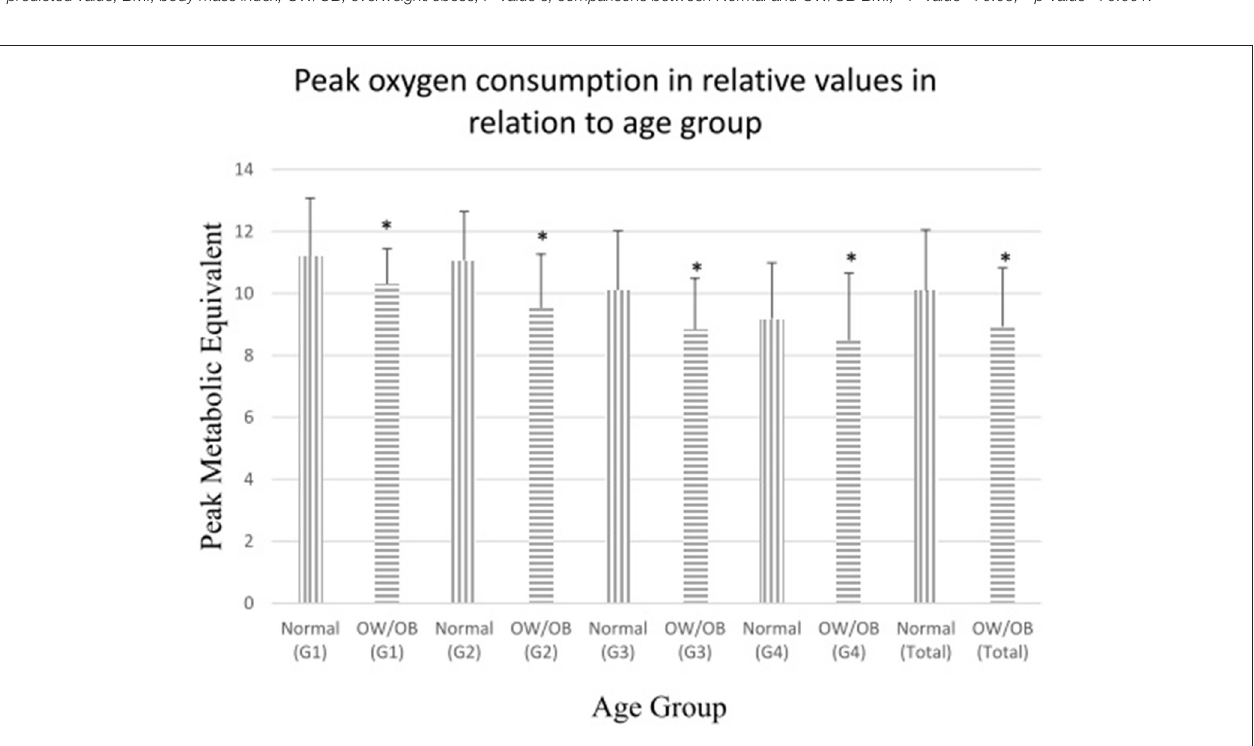
Peak MET (kcal/kg/hour) (kcal/kg/hour)